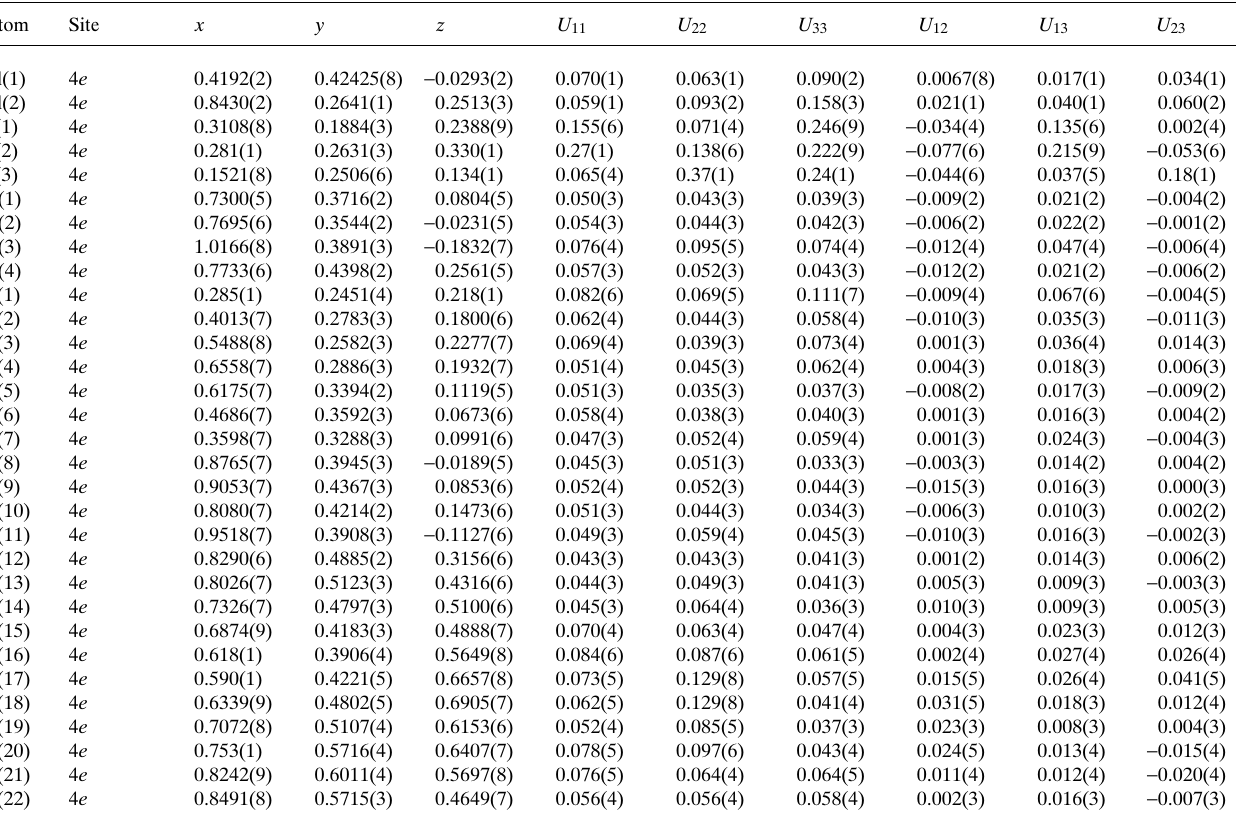
Table 3. Atomic coordinates and displacement parameters (in Å 2 ) .